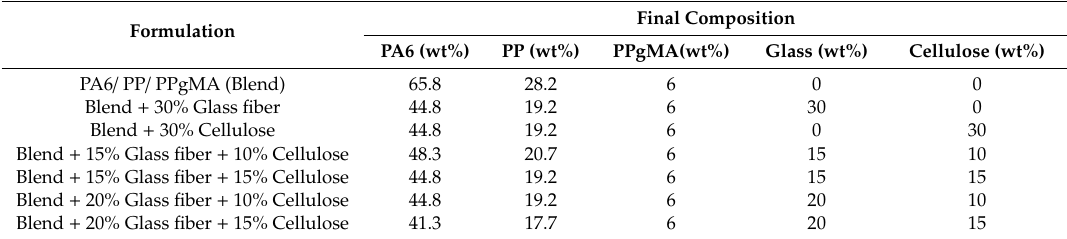
Table 1. Experimental design for the preparation of recycled polypropylene and Nylon 6 blends with hybrid fibers